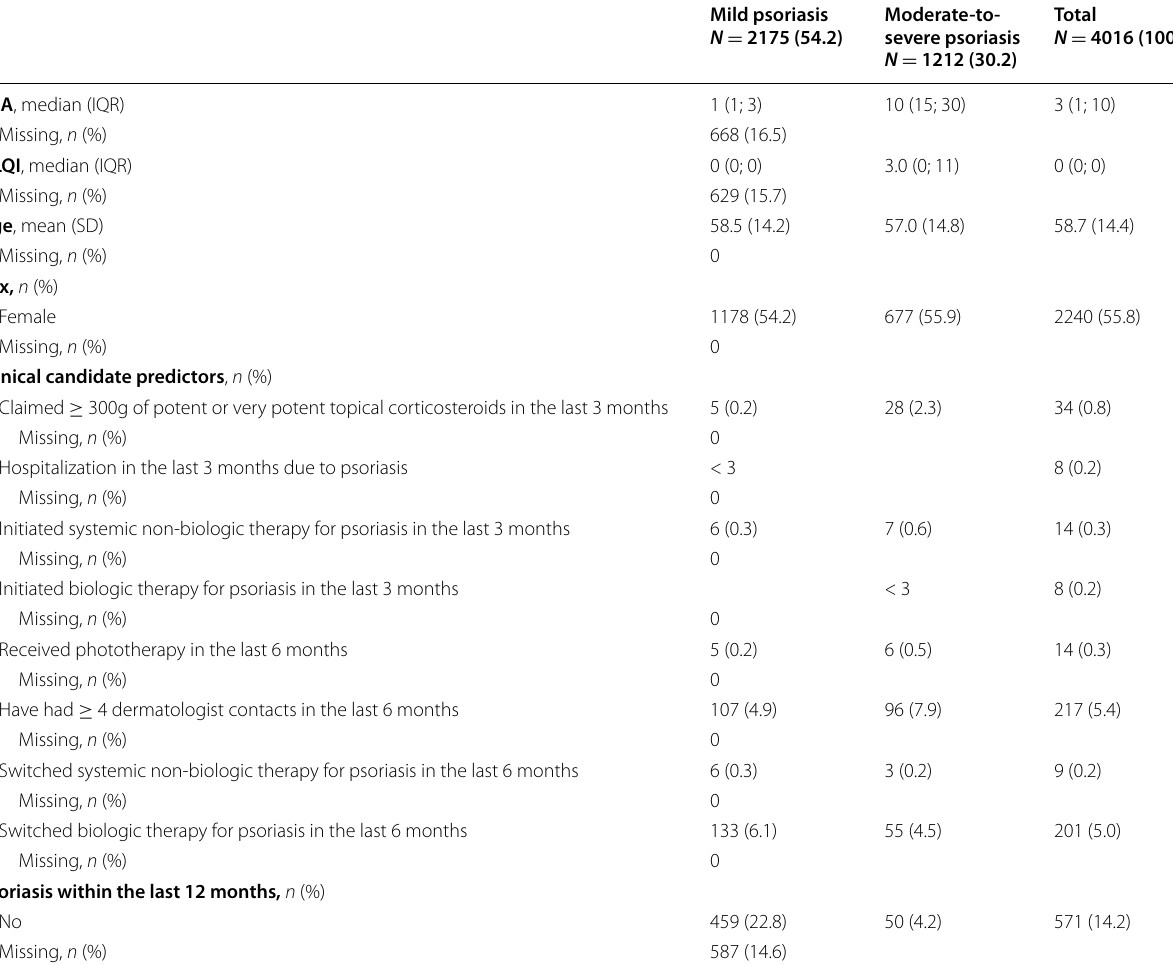
Table 1 Baseline